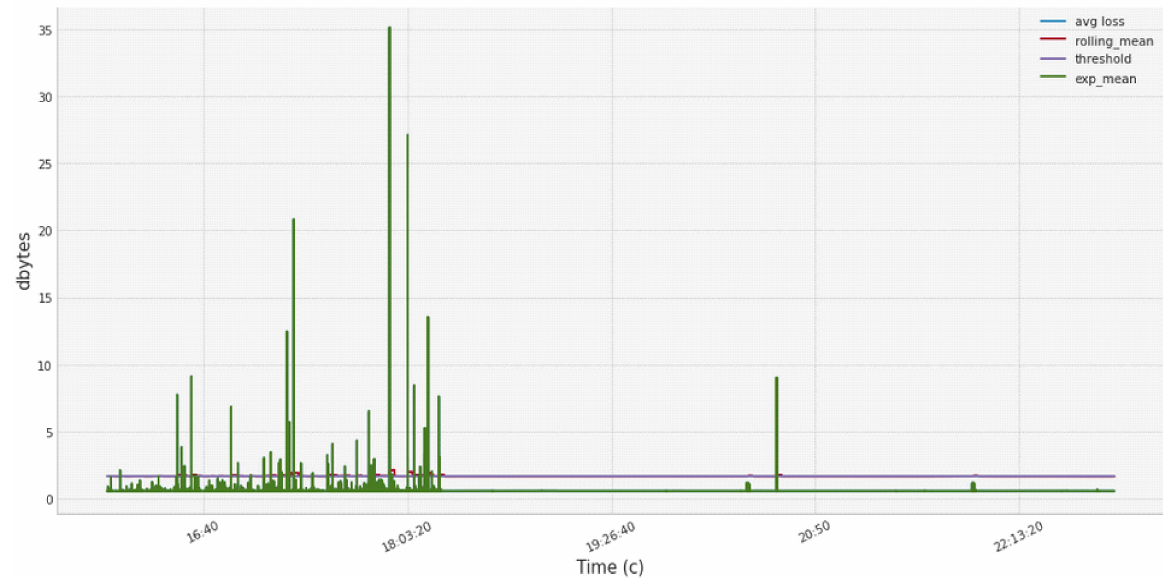
Figure 32. Dynamic threshold on test